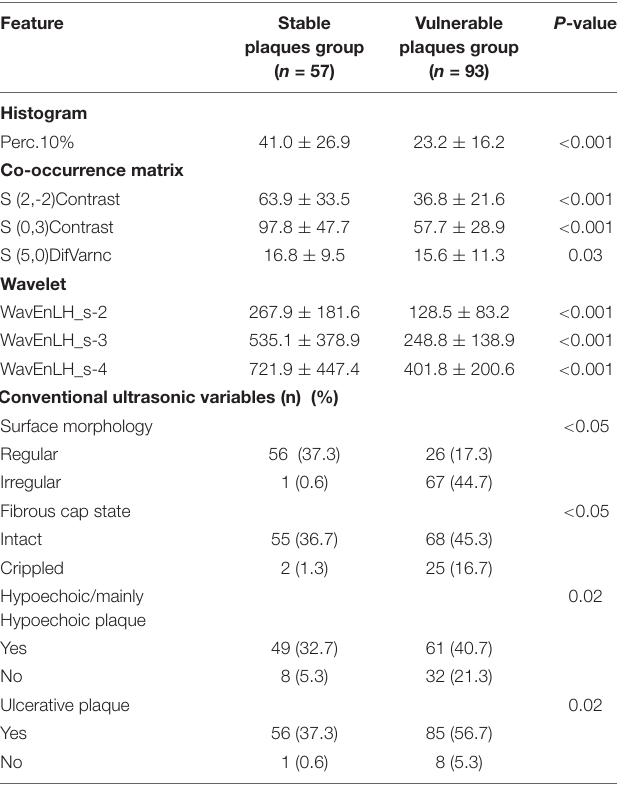
TABLE 2 | Statistically significant texture features extracted from 150 carotid plaques and conventional ultrasonic